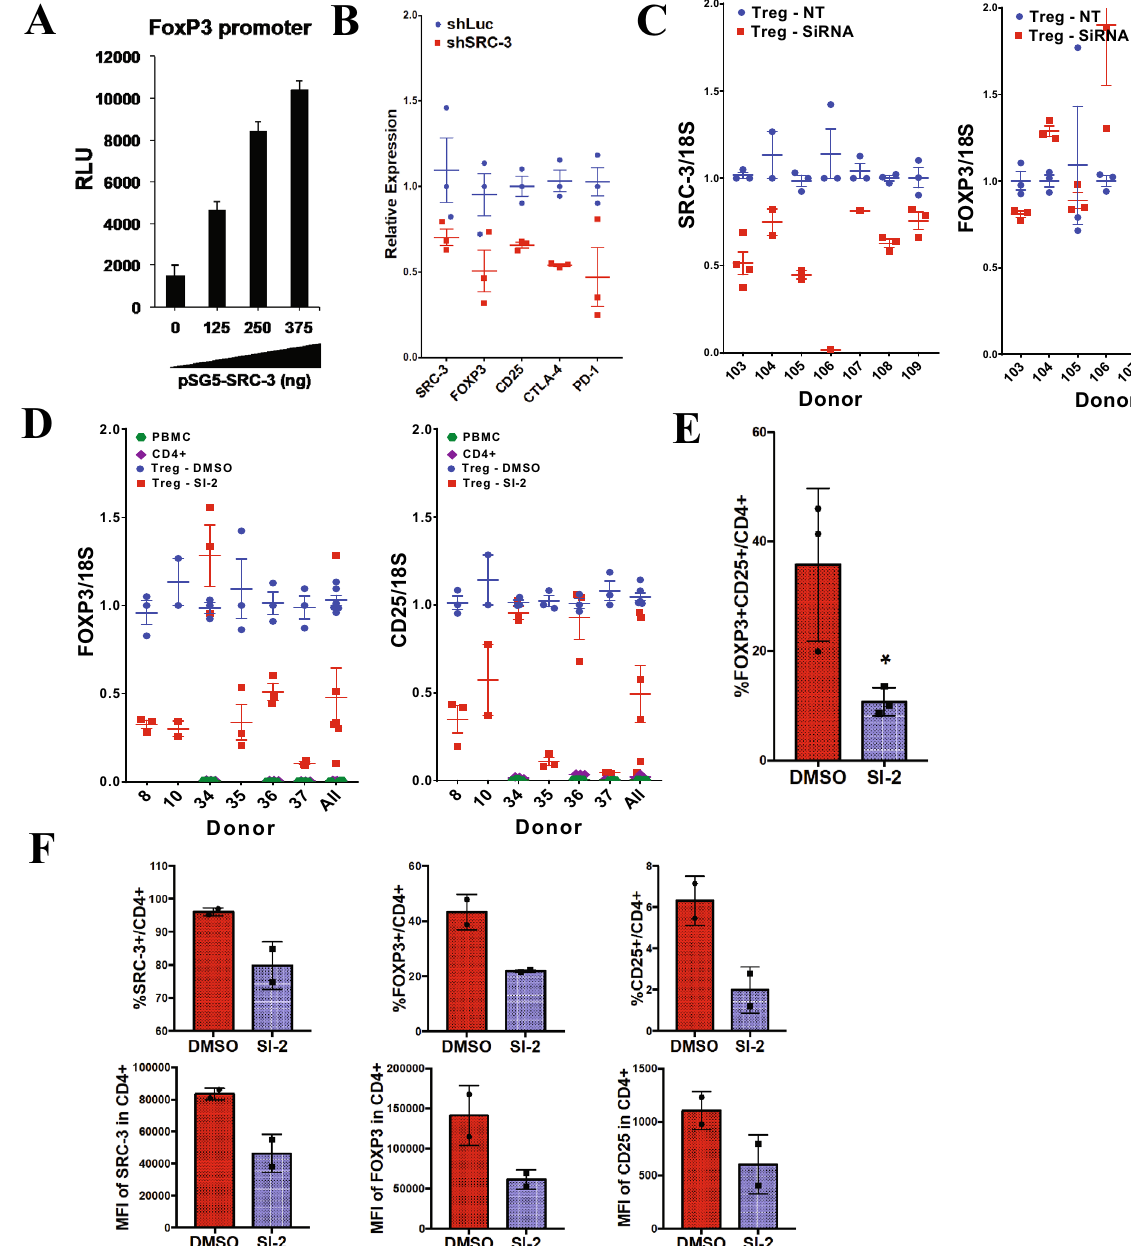
Figure 2. SRC-3 knockdown or inhibition in human Tregs reduces FOXP3 and CD25 levels. ( A ) SRC-3 transactivates FOXP3 promoter in transiently transfection assay. ( B ) RNAi knockdown of SRC-3 in Tregs decreases transcript levels of FOXP3, CD25, CTLA-4, and PD-1 . ( C ) SRC-3 knockdown in Tregs decreases transcript levels of SRC-3 , FOXP3 and CD25 in multiple human donors. ( D ) Inhibition of SRC-3 with SI-2 (100 nM for 12 h) in Tregs decreases transcript levels of FOXP3 and CD25 in multiple human donors. ( E ) SRC-3 inhibition reduces protein expression of FOXP3 and CD25 in Tregs from multiple human donors measured using traditional flow cytometry and ( F ) imaging